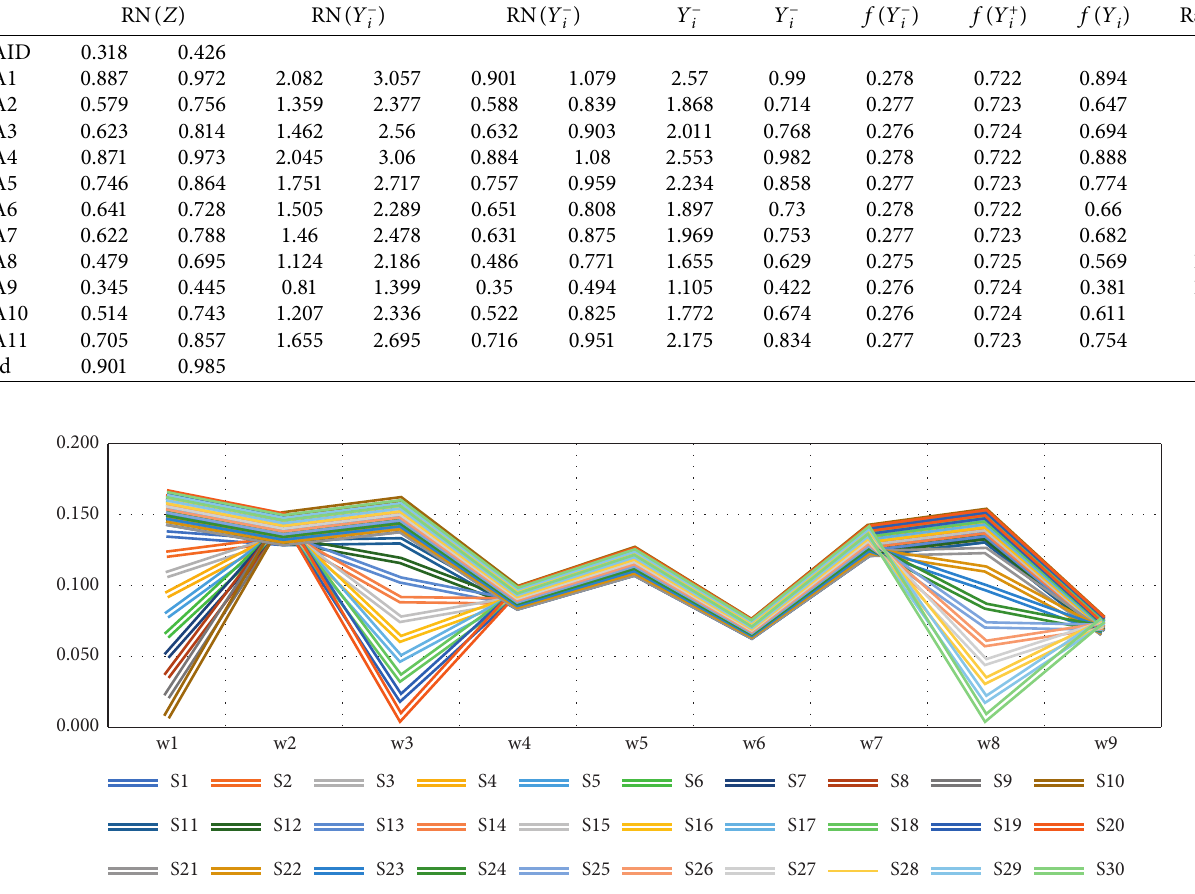
Figure 4: New simulated criteria weights used in the sensitivity